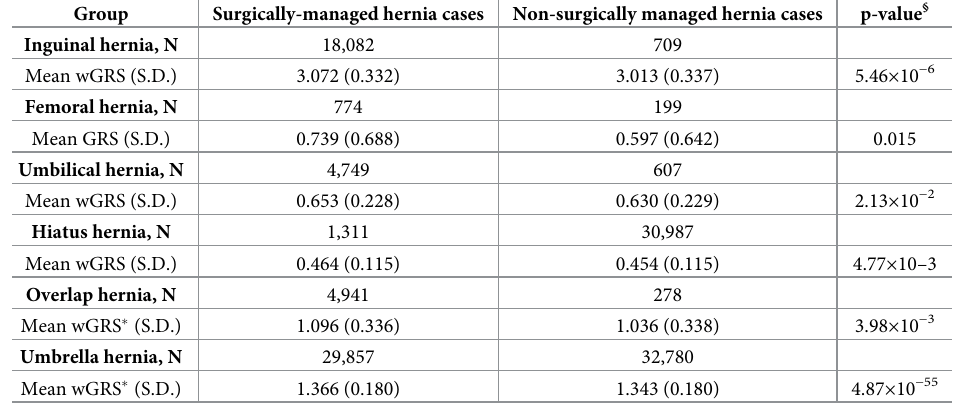
� wGRS: weighted genetic risk score.